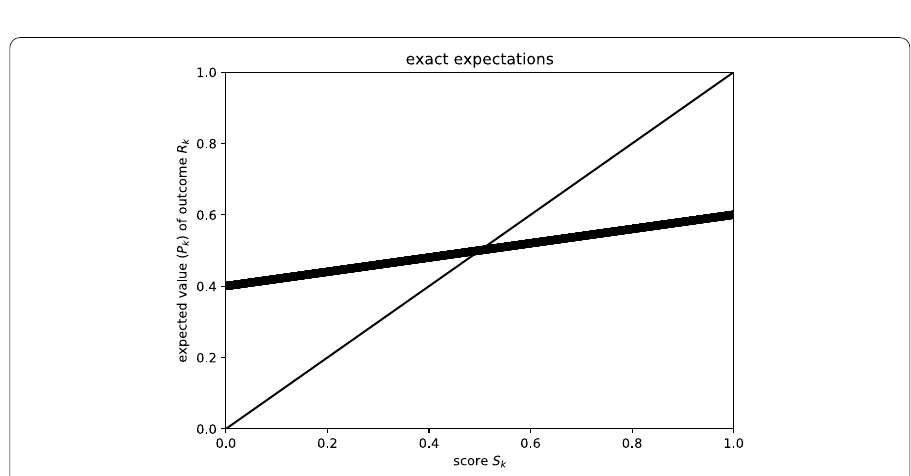
Fig. 29 Ground-truth reliability diagram for Figure